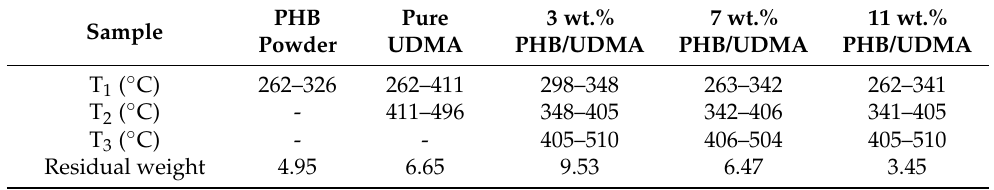
Table 6. Thermal events of thermal degradation and their corresponding of weight loss